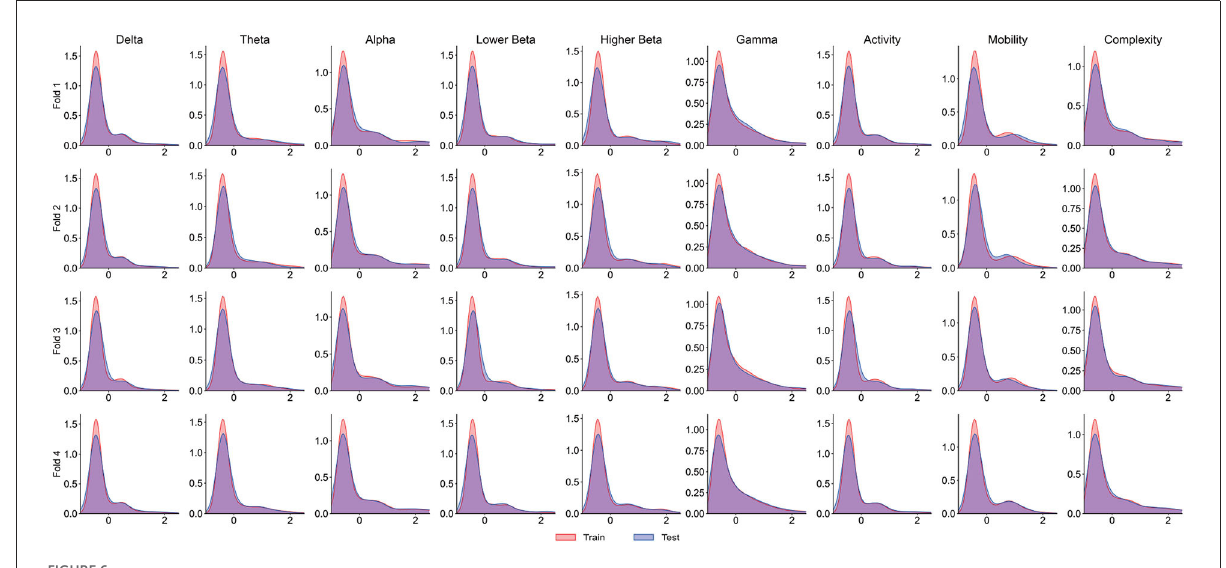
FIGURE6 The distribution curve of the training set and test set of sub14.